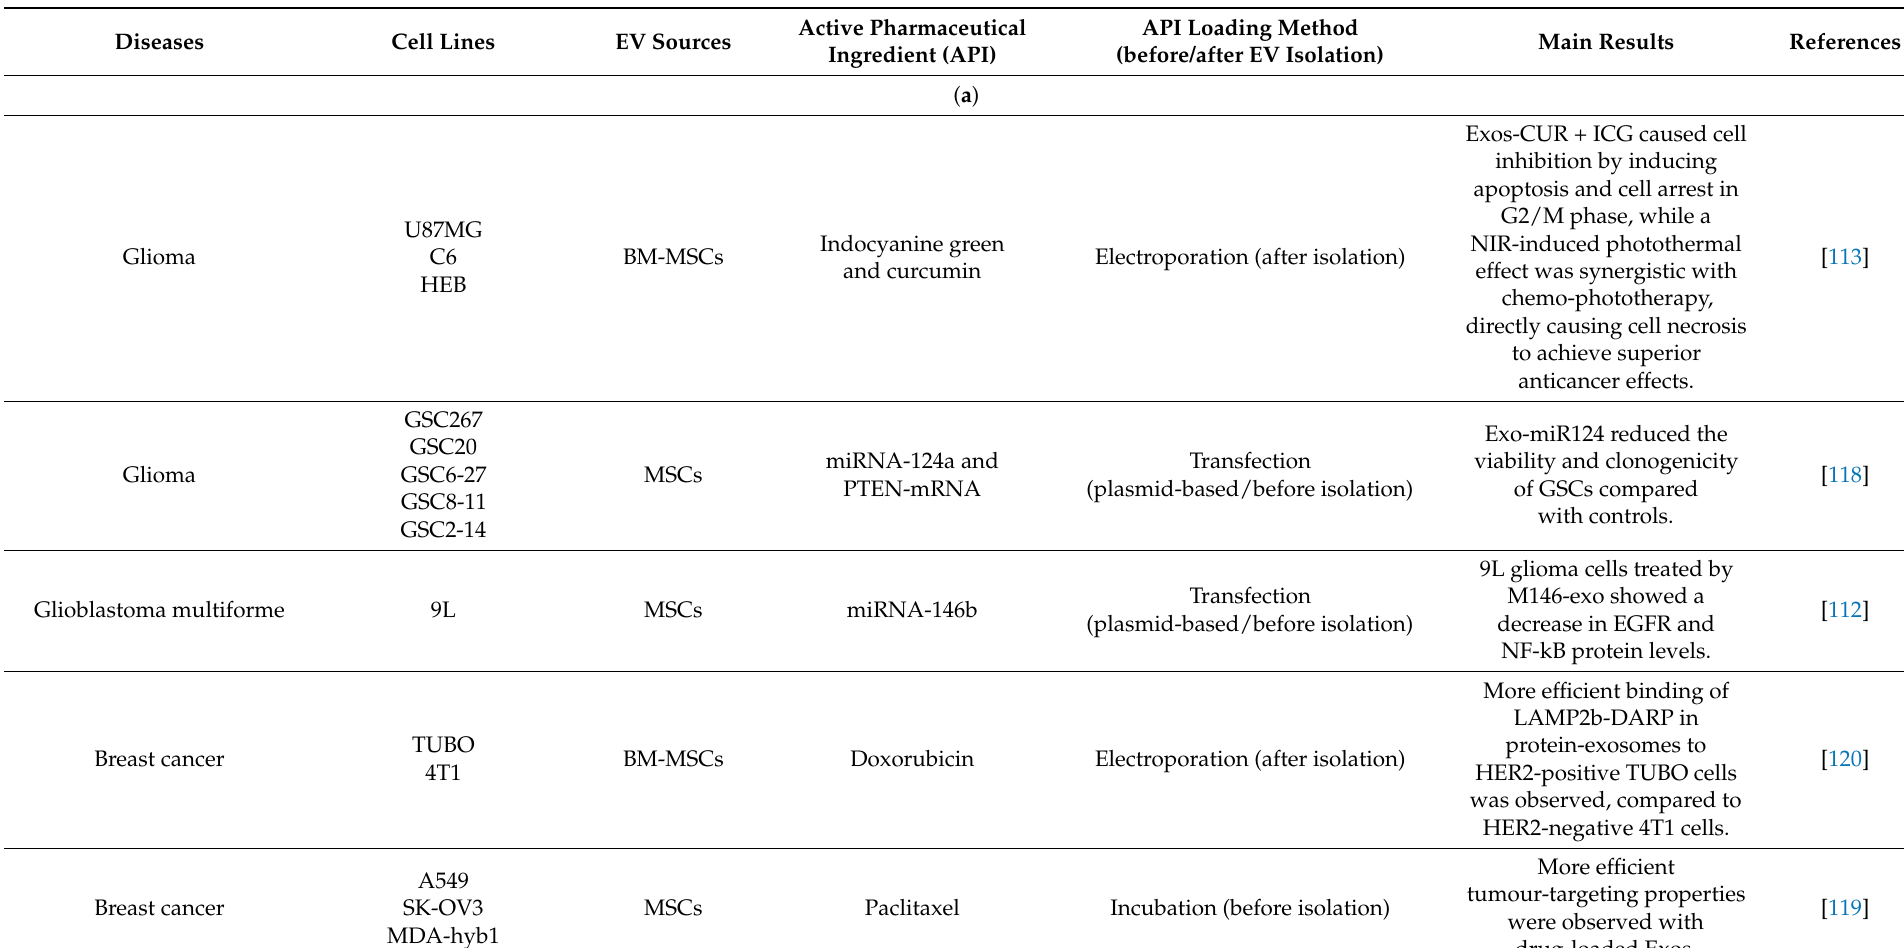
Table 3. ( a ) Pre-clinical in vitro studies using EV as DDS in cancerous pathologies. ( b ) Pre-clinical in vitro studies using EVs as DDS in non-cancerous